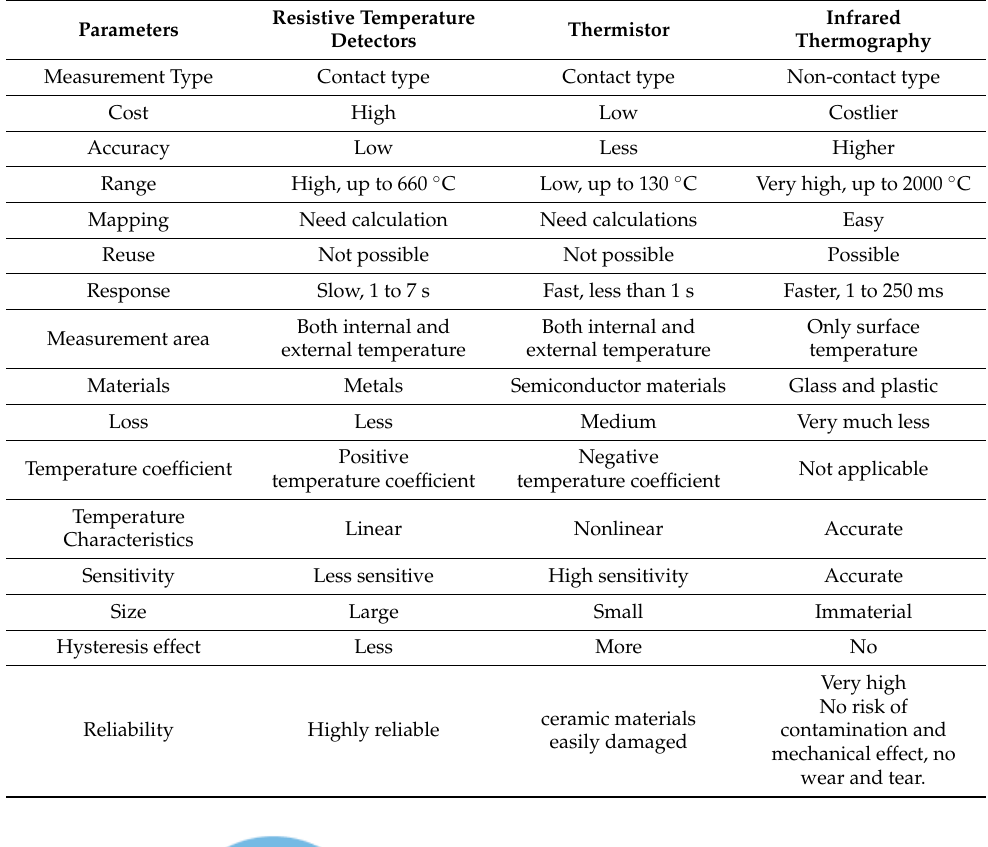
Table 2. Comparison of different thermal mapping techniques against operating parameters.